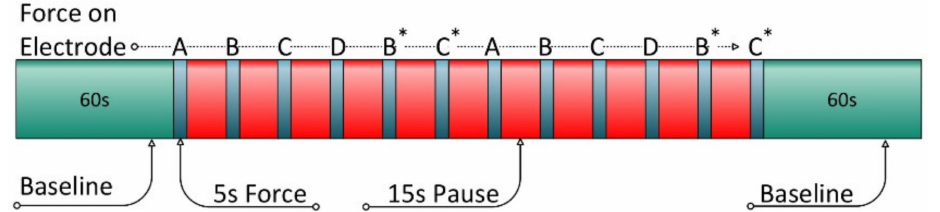
Figure 9. Timeline force test —green-marked are baseline at the start and the end, red-marked are the pauses between the disturbances and the letter indicates the corresponding electrode with push/pull forces. The asterix marks the electrodes for the second parallel measurement.